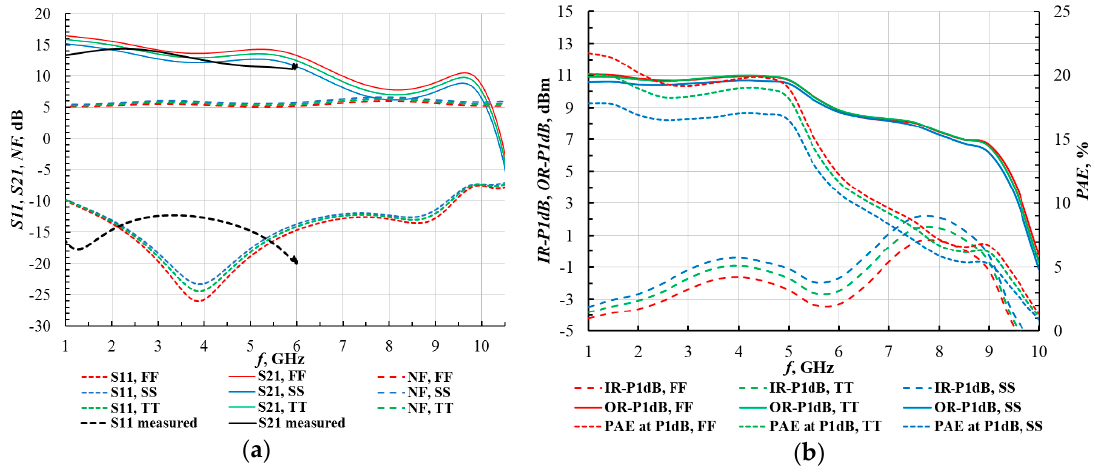
Figure 5. Traveling-wave amplifier chip simulation and measurement results: ( a ) TWA2 with on-chip gate termination SP simulation and measurement results, ( b ) TWA2 with on-chip gate termination HB simulation results.